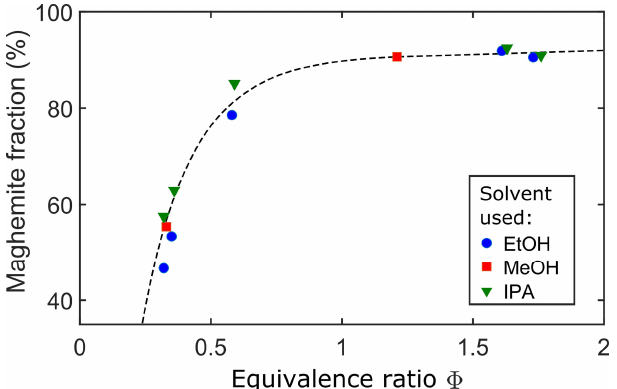
Figure 3. Mass content of the maghemite phase in flame-synthesized iron-oxide NPs as a function of φ , using different alcohols for the precursor solution [12].